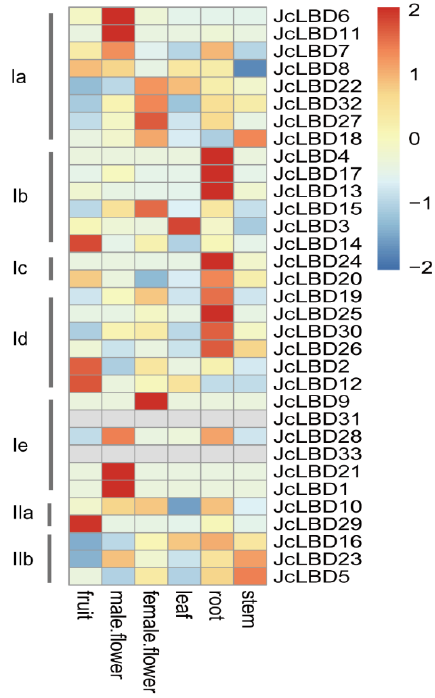
Figure 7. Tissue expression patterns of JcLBD s. Heatmap of expression levels of 33 JcLBD genes in different tissues. fruit: immature fruit; male flower: fully open; female flower: fully open; leaf: fully mature; root: fully expanded; stem: fully mature. Heatmap was drawn by pheatmap using log10(TPM) values.